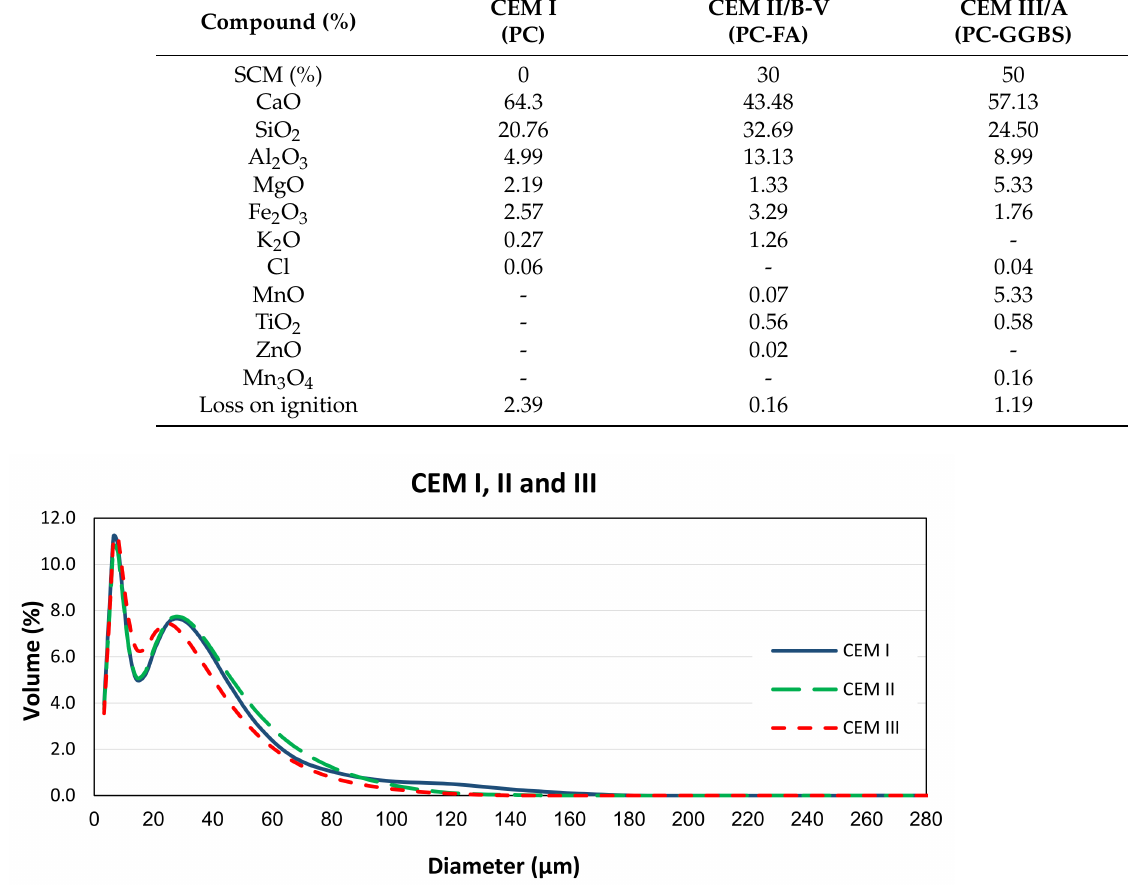
Table 1. Chemical analysis of CEM I, II, and III [6].